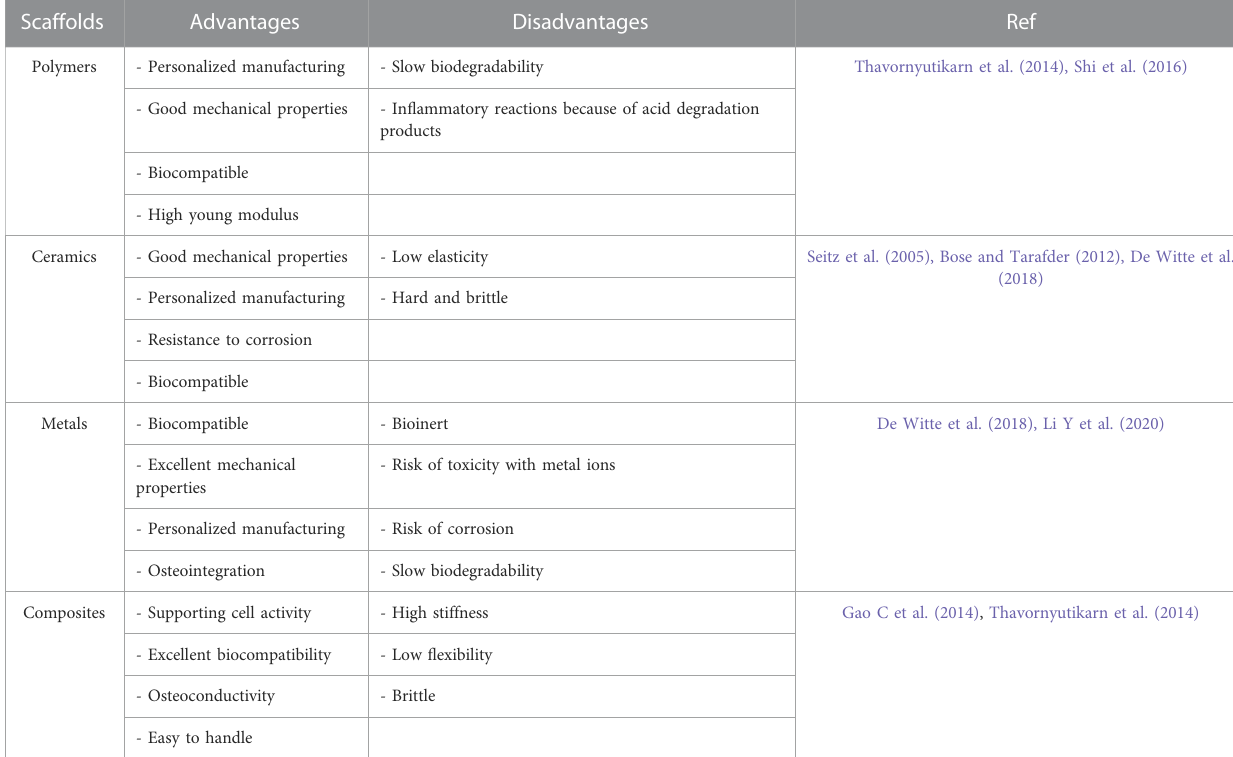
TABLE 1 The advantages and disadvantages of the most used scaffolds in BTE.